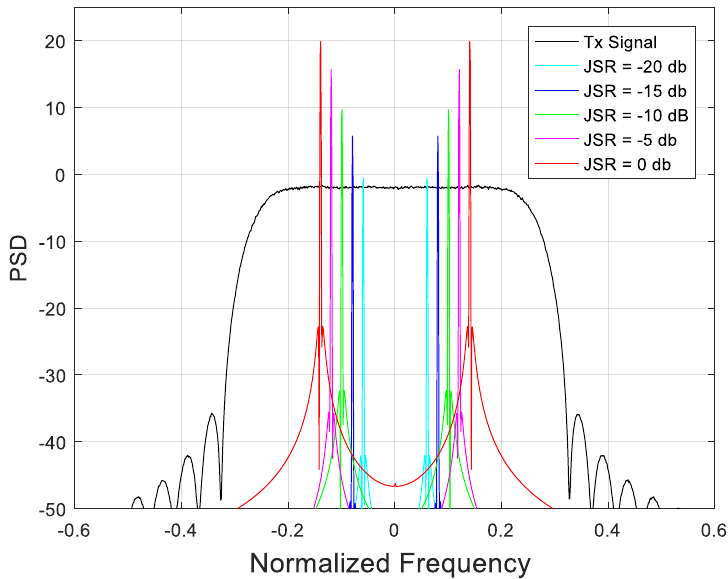
Figure 1. The effect of varying the JSR parameters on the received PS signal.